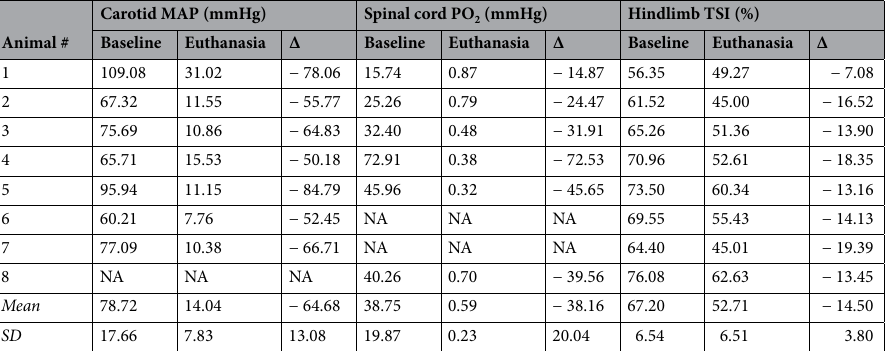
Table 1. Carotid blood pressure, spinal cord PO 2 and transcutaneous NIRS measurements at pre-euthanasia baseline (averaged over 60 s), 5-min post euthanasia (average of the last 10 s of recording) and ΔMAP, spinal cord PO 2 and TSI (%) values. (Note on missing values: MAP values from one experiment were excluded as signal quality significantly deteriorated shortly after pentobarbital administration. In 2/8 experiments, data on spinal cord PO 2 was unavailable due to modifications in the original experimental protocol). TSI (%) tissue saturation index, MAP mean arterial pressure, PO 2 partial pressure of